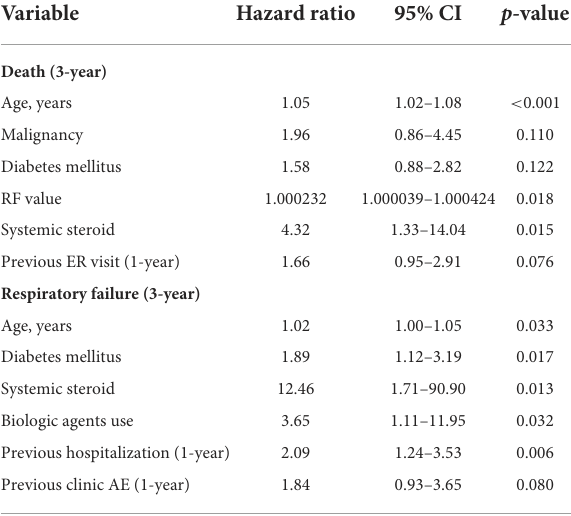
TABLE 4 Stepwise cox regression model of 3-year mortality and respiratory failure.